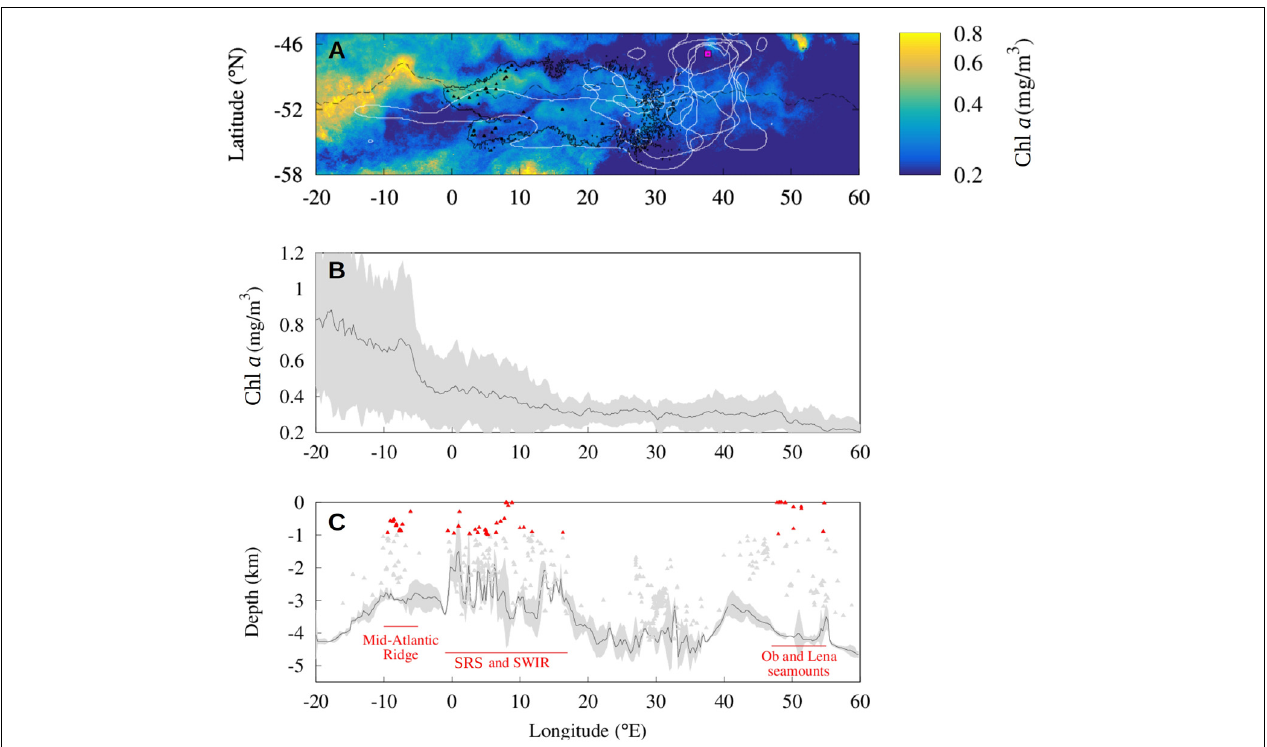
FIGURE 5 | Distribution of predators, Chl a concentration and seamount mass effect during December between 2000 and 2015 around the PF current core. (A) The distribution of top predators (white lines) from the Prince Edward Islands (magenta square) is compared to the distribution of the Lagrangian plumes (black solid line) constructed from the seamounts (black triangles) for every December between 2000 and 2015. Data are displayed with the Chl a climatology and the PF position (black dashed line) during December between 2000 and 2015. (B,C) Mean Chl a concentration (B) and mean shallowest depth (C) in a latitudinal band of 1 ◦ north and 1 ◦ south of the current core for every December from 2000 until 2015. Shaded areas show standard deviation associated with these lines. Gray and red triangles indicate the depth of the seamounts (respectively, deeper and shallower of 1000 m) identified by Yesson et al. (2011) in the same region (C)